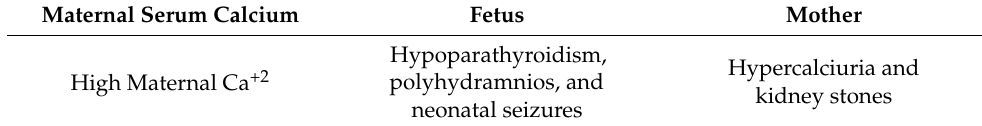
Table 3. Reported maternal and fetal adverse events in HypoPT [8,11,13,17,18,36,70–75]. Maternal Serum Calcium Fetus Mother High Maternal Ca